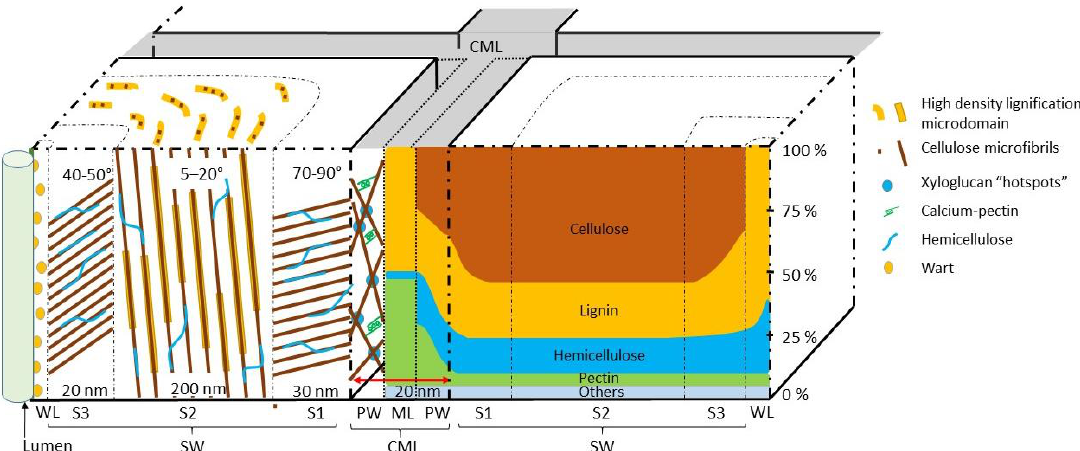
Figure 5. Cell wall model for hardwood from the middle lamellae to the lumen. ML: mid-lamella; PW: primary wall; CML: compound mid lamella; SW: secondary cell wall; WL: warty layer. This scheme represents the cell wall corner between four cells after the secondary cell wall formation. It shows the arrangement and the distribution of the various components of the cell walls. The grey area is the CML separating the four cells. On the left-hand side, the angle of the cellulose microfibrils and the width of the various layers (S1, S2, S3 and CML) can be found. In the secondary cell wall, the hemicellulose is distributed alongside one or linking two cellulose microfibrils. Some microdomains of high density lignification can be found in the S2 layer. In the primary cell wall, the microfibrils are not oriented. The microfibrils are held together in xyloglucan hotspots, and some calcium-pectin complexes have a load-bearing function between different fibres. On the right-hand side is the percent distribution of the various constituents of the cell wall.ML: mid lamellae, PW: primary wall, CML: compound mid lamellae, SW: secondary cell wall, WL: warty layer.